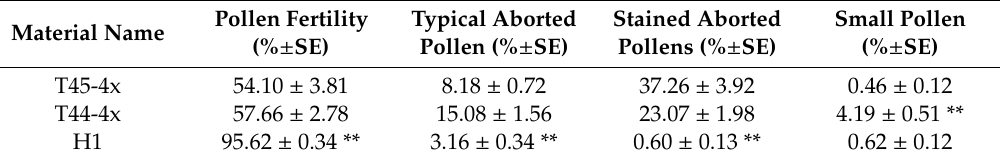
Table 2. Pollen fertility of neo-tetraploid rice and its parents.